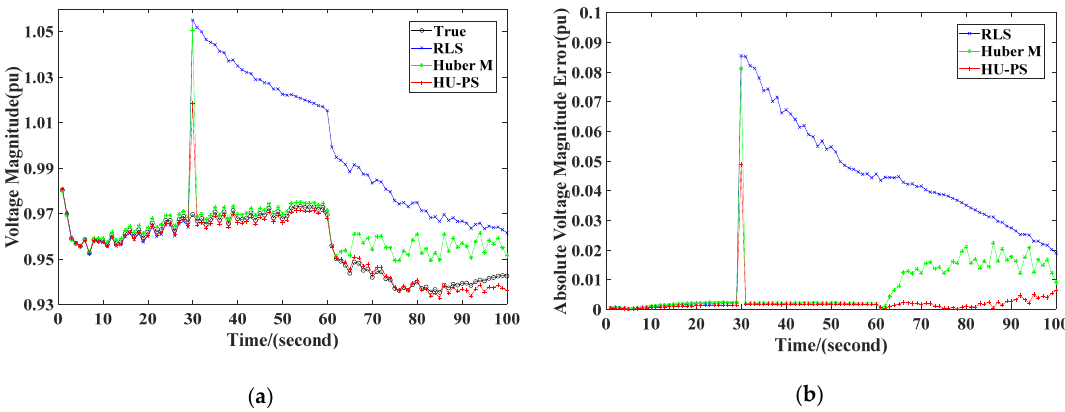
Figure 12. Values in scenario 2: ( a ) voltage magnitude, ( b ) absolute voltage magnitude error.